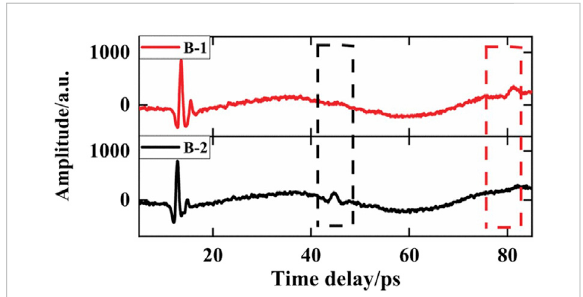
FIGURE 9 THz time domain waveforms in the debonding and metal foreign matter regions (Li et